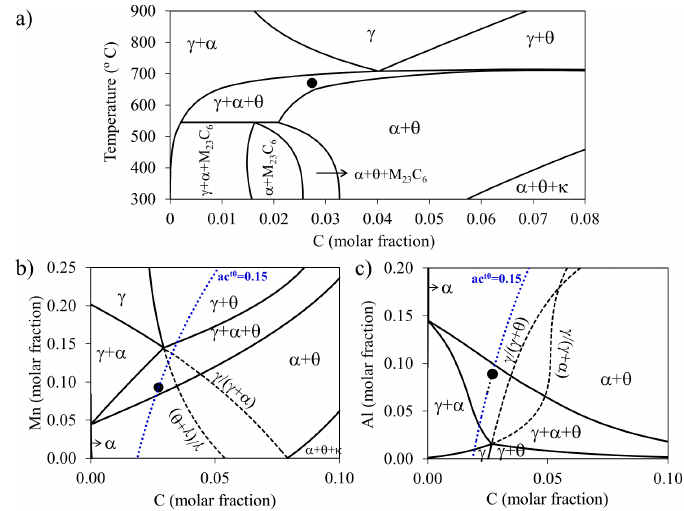
Figure 1. ( a ) Isopleth section of the Fe–C–Mn–Al system at 0.0930 Mn–0.0886 Al (molar fraction), showing that at 670 °C the alloy composition (represented by the solid circle) is located within the three-phase ( γ + α + θ ) field region. Isothermal section at 670 °C for the studied steel at ( b ) 0.0886 Al (molar fraction) and ( c ) 0.0930 Mn (molar fraction) fixed. The blue dotted line is the carbon isoactivity line at the early stages of the transformation (ac t0 ) and the black dashed lines are the extrapolated γ /( γ + α ) and γ /( γ + θ ) phase boundaries ( κ symbolises Kappa-carbide and it does not participate in reactions in this study).